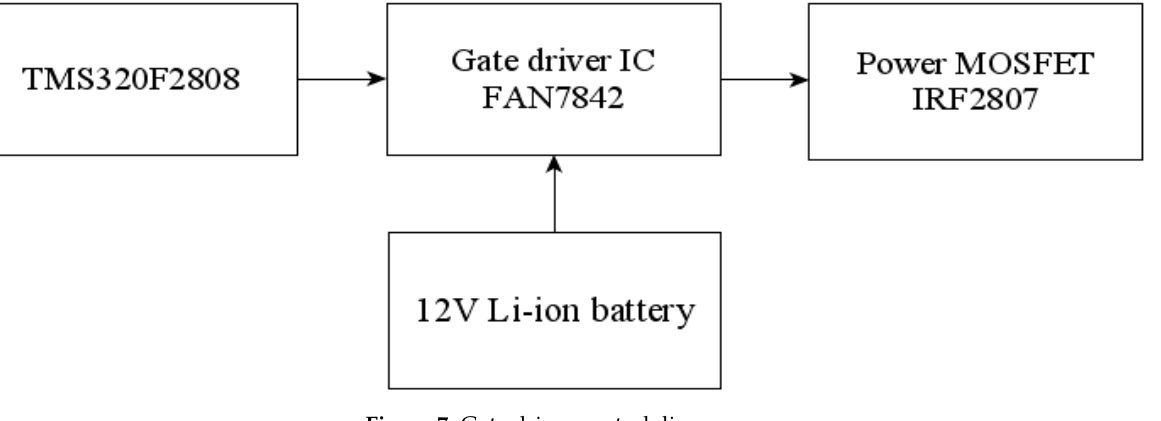
Figure 7. Gate driver control diagram.